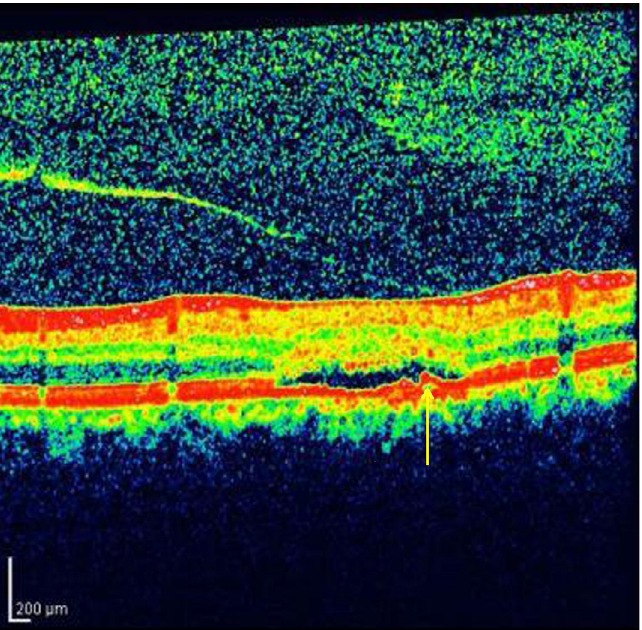
Figure 3: A Spectral OCT image demonstrating the pigment epithelial protrusion (yellow arrow) in ACSC.